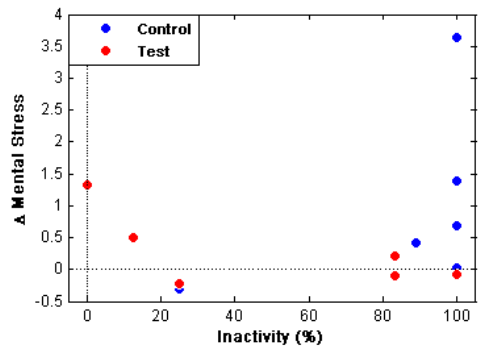
Figure 4: Inactivity and changes in subjective measures of mental